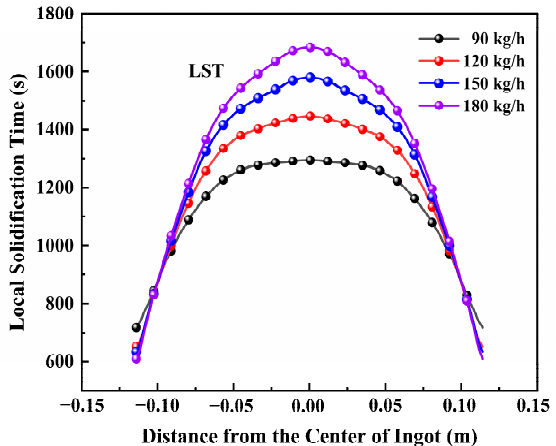
Figure 9. Change of LST along radical direction with varying melting rate.